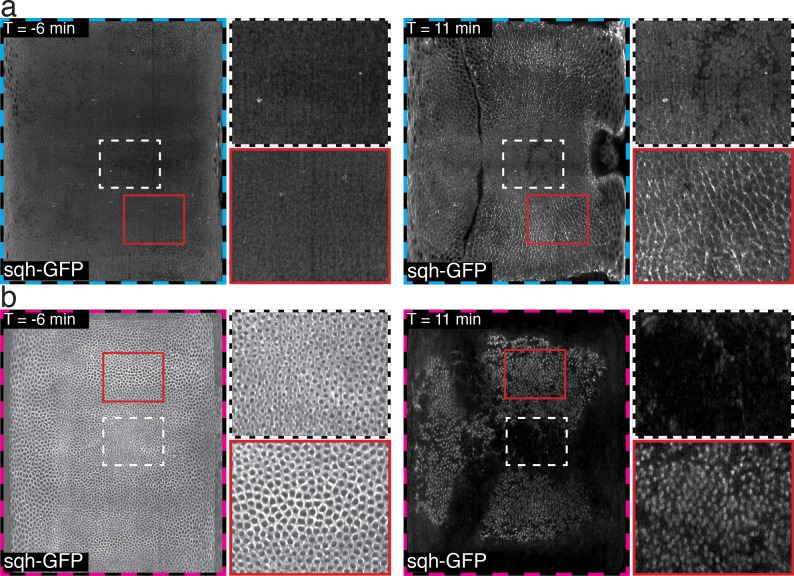
Magnified view of time course of Myosin on basal surface, as described in Figure 1—figure supplement 1e,g.(a) apical surface. (b) basal surface. Note that in contrast to Figure 1—figure supplements 1–3, the lookup table has been adjusted in each time point separately, to enhance visualization.